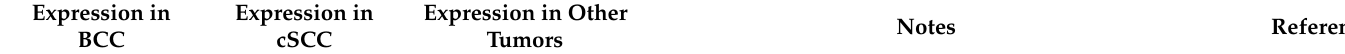
Table 2. Expression and function of developmental core ESC, EMT and oncofetal genes in KC tumors and other keratinocytic skin tumors. +: positive